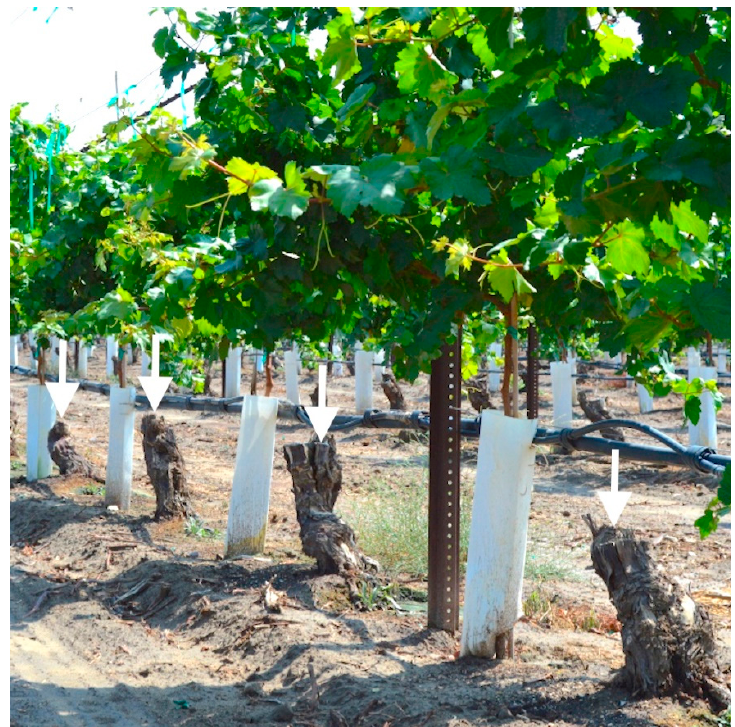
Figure 1. Vineyard with new vines inter-planted between old vine stumps (white arrow).